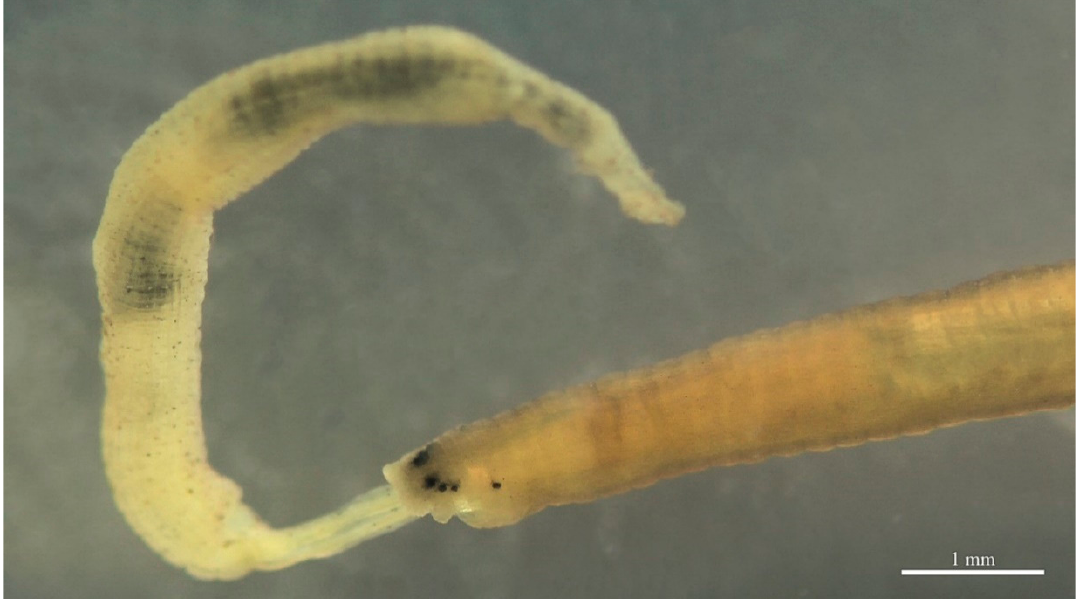
Figure 6. Dinaric land leech ( Xerobdella anulata ; right) feeding on a microdrile oligochaete of the family Enchytraeidae.